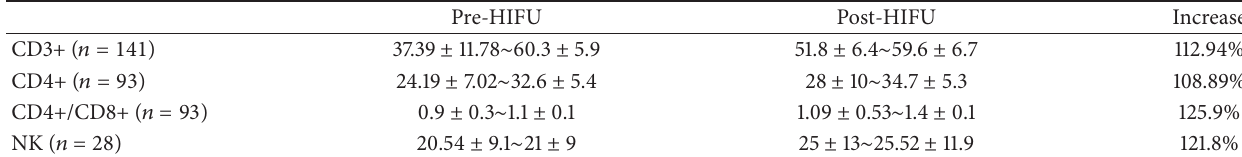
Table 5: Statistical summary of immune factors before and after HIFU ablation in pancreatic cancer patients. Pre-HIFU Post-HIFU